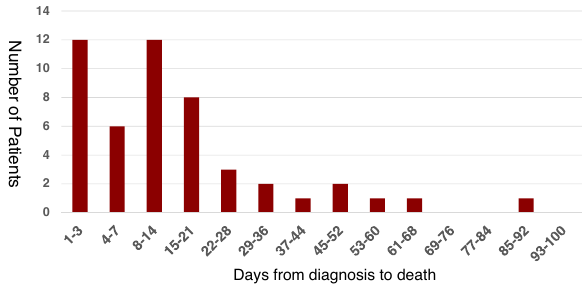
Figure 2. Correlation between the number of patients who died and days from diagnosis to death. Fifty (48%) of 104 patients in our series died during the 180-day study period, and 82% (41 deaths) of all deaths occurred within the first 28 days. Eighteen (36%) of the 50 nonsurvivors died within six days (< 7 days) of diagnosis (median, 2 days, IQR [1, 5]; early death group). The other 32 patients (64%) died after day 7 (≥ 7 days) (median, 16 days, IQR [13, 29]; late death